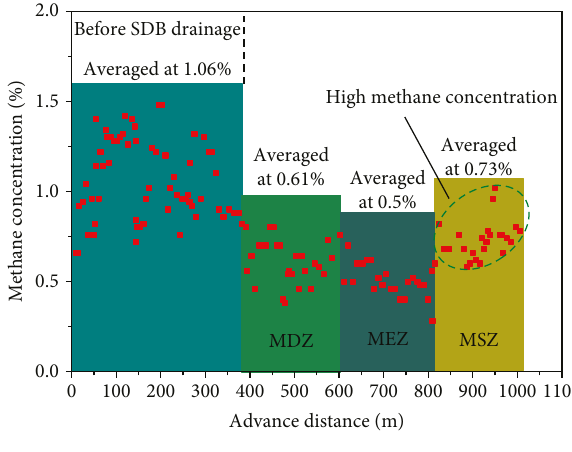
Figure 7: Methane concentration variations of the upper corner as the working face advancement distance